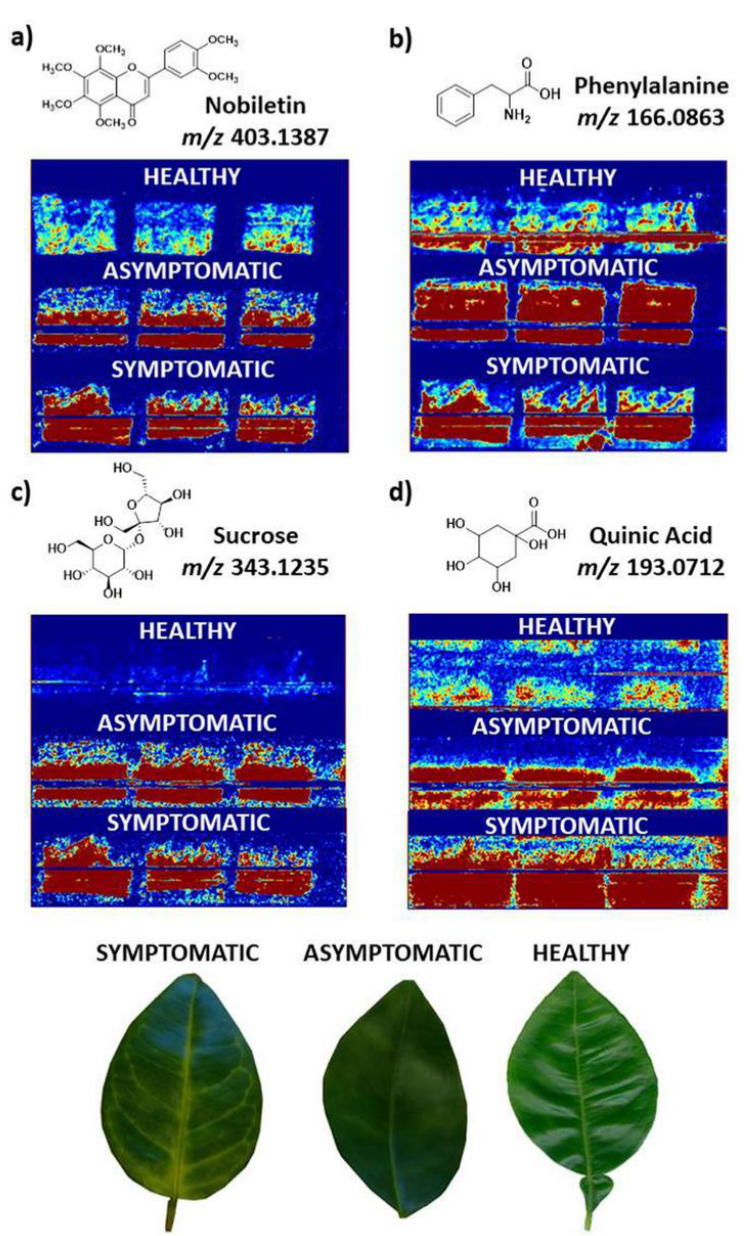
Figure 7. Images acquired for the various biomarkers identified for HLB disease with DESI MSI in positive ion mode. In the images acquired, the red colour indicates the ion distribution on the abaxial leaf surface in asymptomatic, symptomatic and healthy samples. The images acquired were at: ( a ) m/z 403; ( b ) m/z 166; ( c ) m/z 343 and ( d ) m/z 193, which were the exact masses found in Xcalibur software (m/z 403.1387, m/z 166.0863, m/z 343.1235, and m/z 193.0712) corresponding to nobiletin, phenylalanine, sucrose and quinic acid, respectively. Figure reproduced with permission from de Moraes Pontes et al. [48].